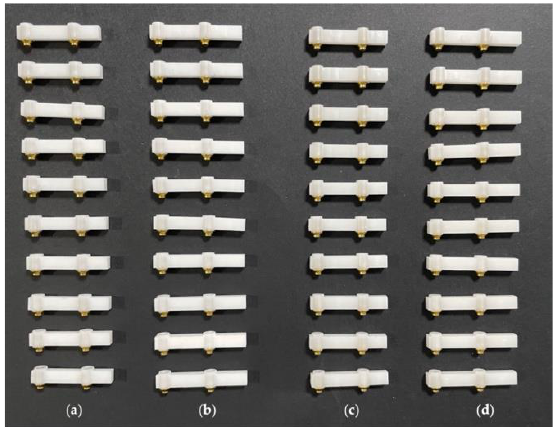
Figure 1. Study structures: ( a ) 6 mm Ice Zirkon Translucent cantilever; ( b ) 10 mm Ice Zirkon Translucent cantilever; ( c ) 6 mm Prettau ® Zirconia cantilever; ( d ) 10 mm Prettau ® Zirconia cantilever.